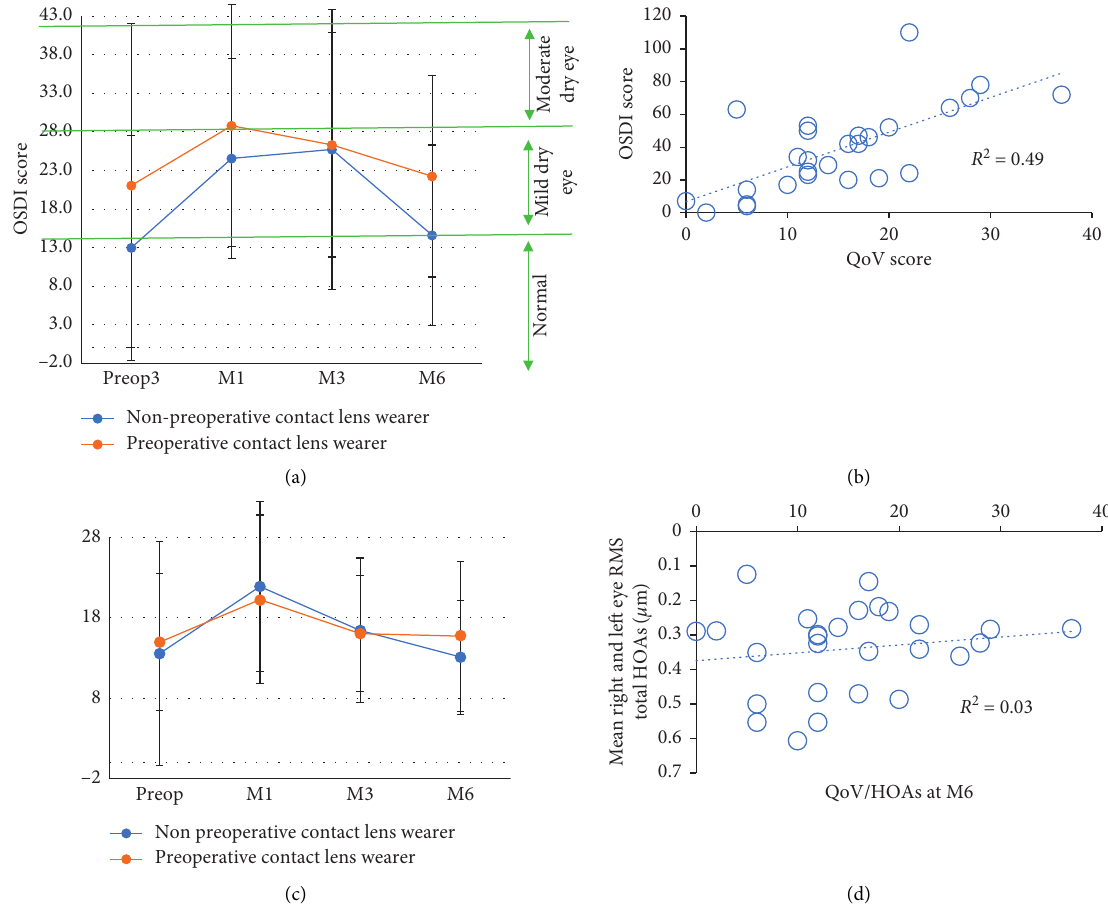
Figure 12: Evolution of QoV (a) and OSDI (c) scores and relationship between the QoV score and the OSDI score (b) and total HOAs